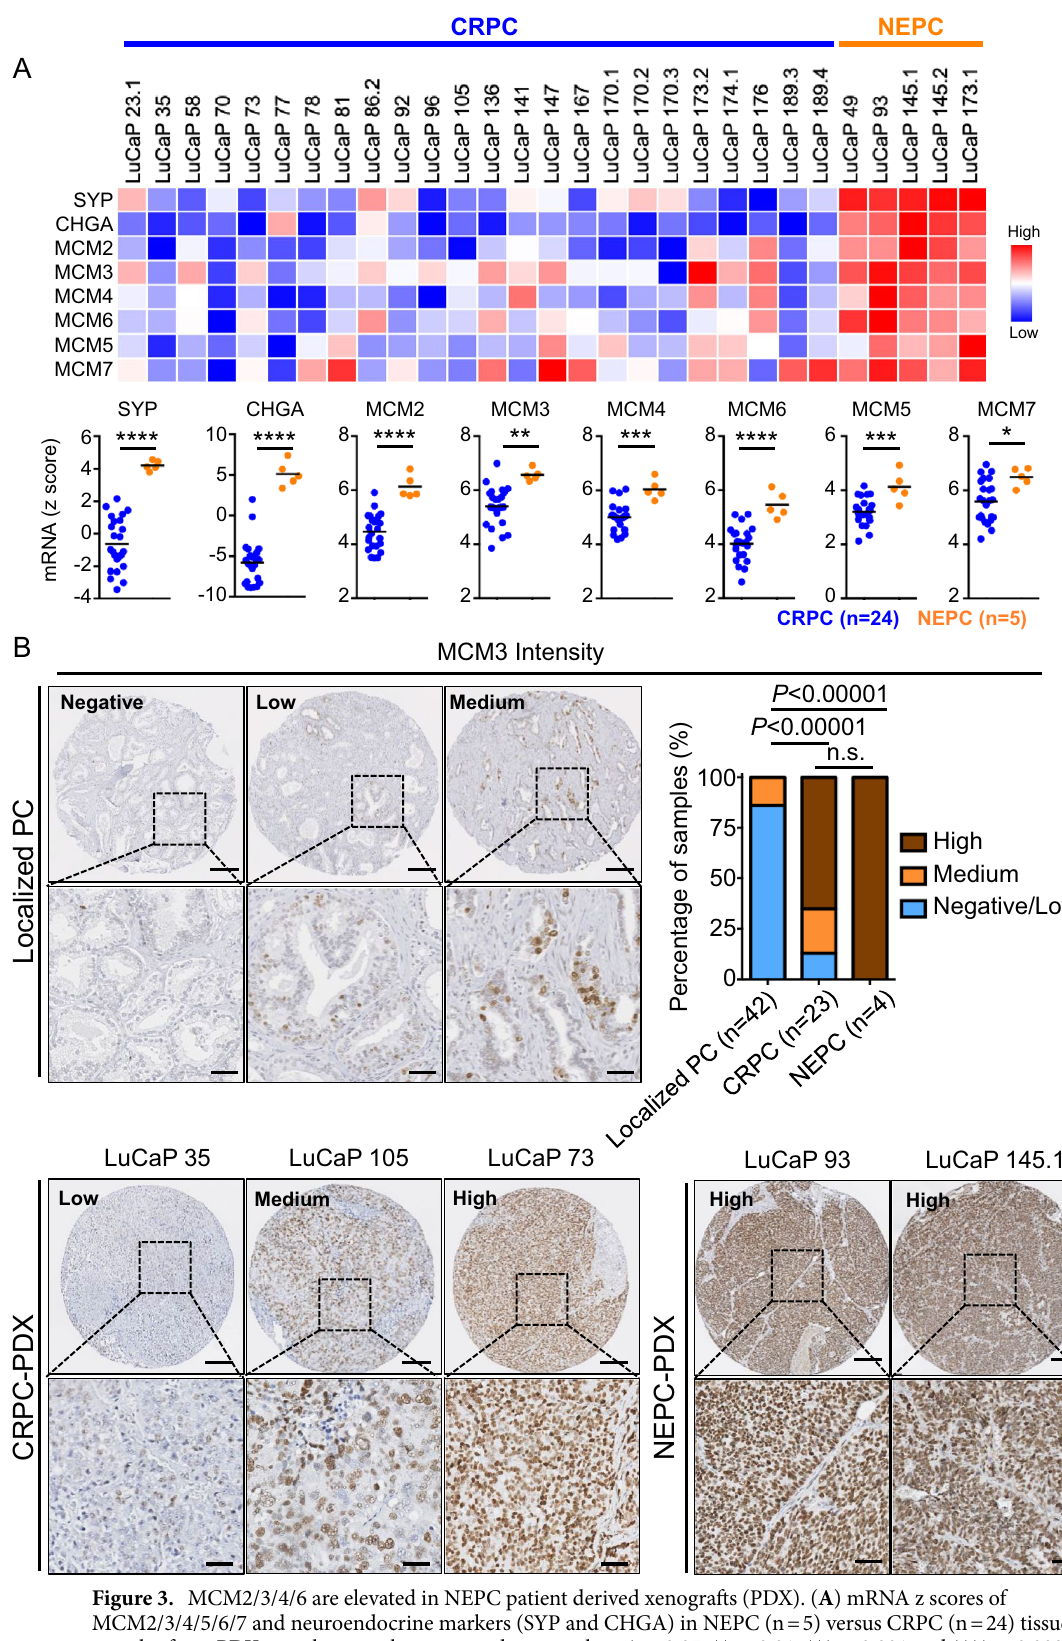
Figure 3. MCM2/3/4/6 are elevated in NEPC patient derived xenografts (PDX). ( A ) mRNA z scores of MCM2/3/4/5/6/7 and neuroendocrine markers (SYP and CHGA) in NEPC (n = 5) versus CRPC (n = 24) tissue samples from PDXs are shown as heatmap and scatter plots. * p < 0.05, ** p < 0.01, *** p < 0.001 and **** p < 0.0001, determined by Student’s t test. ( B ) MCM3 IHC in localized prostate cancer and PDX TMAs is shown. Scale bars represent 200 µm and 50 µm respectively. The intensity of IHC staining for MCM3 was scored as negative, low, medium, and high and plotted. p < 0.00001 by z-score test for two population